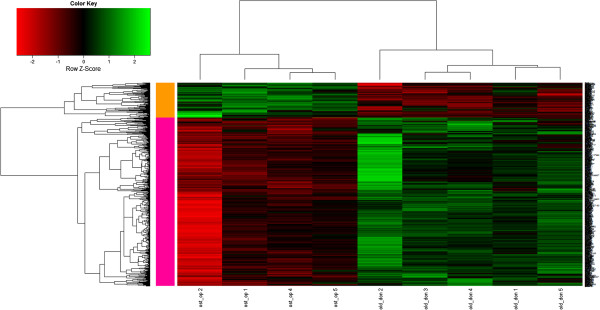
Dendrogram of differentially expressed genes (DEGs) by cluster analysis. The abscissa axis below represents specimen names; ost-op represents MSC specimens of osteoporosis; old-done represents a MSC specimen of normal osseous tissue. The abscissa axis above represents the clustering of specimens. The left longitudinal axis represents genes, and the right longitudinal axis represents the clustering of genes. Red shows up-regulated genes while green shows down-regulated genes. There are two clusters of specimen clustering: one of MSC specimens of osteoporosis and another of MSC specimens of normal osseous tissue; and two clusters of gene clustering: down-expression genes, and up-expression genes in MSC specimens of osteoporosis.